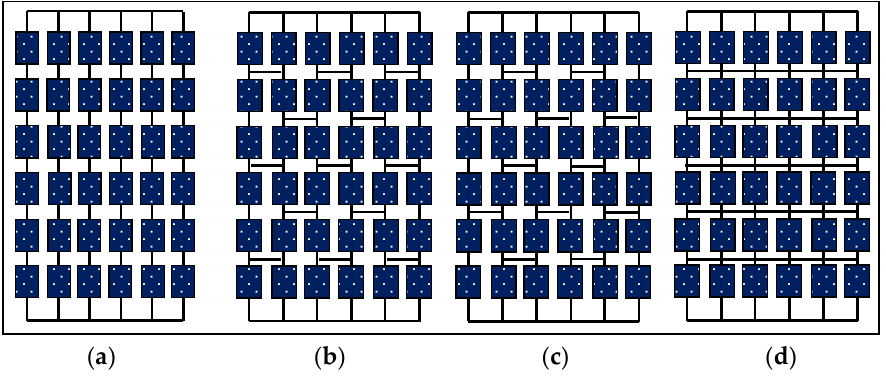
Figure 2. Conventional configurations for 6 × 6 array. ( a ) Series – parallel, ( b ) bridge-Linked, ( c ) hon- eycomb, and ( d ) total-cross-tied.